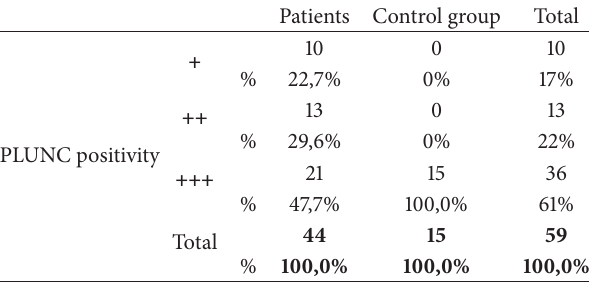
Table 1: PLUNC proteins positivity in cases and